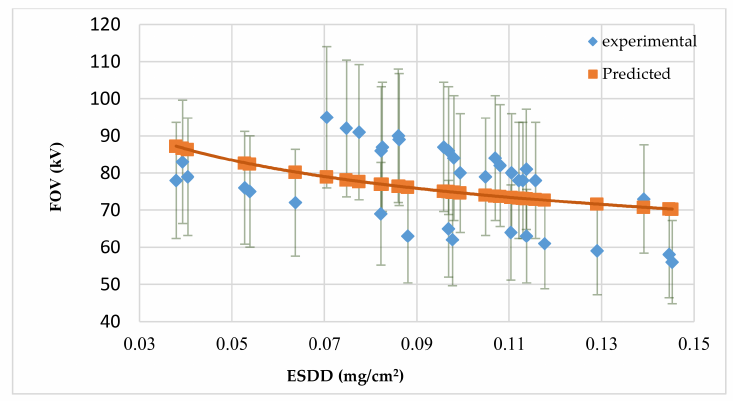
Figure 6. ESDD based FOV model curve for predicted and experimental values.